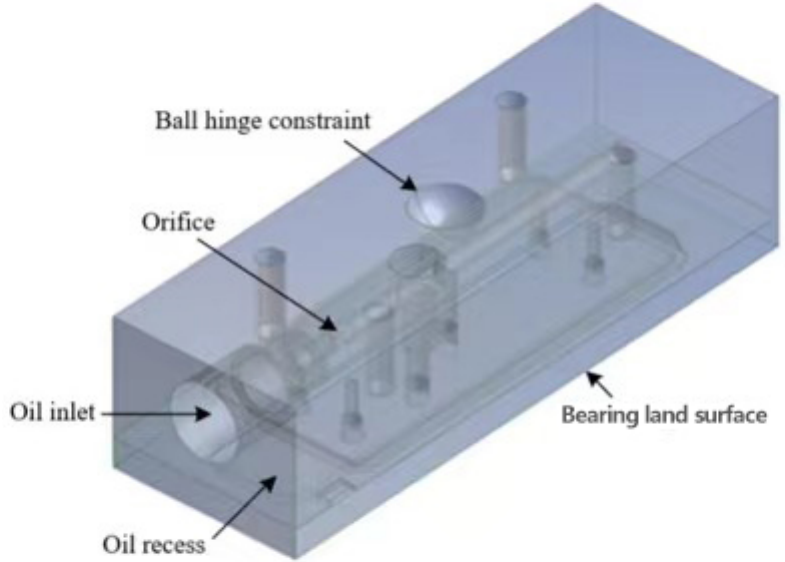
Figure 3. CAD model of the hydrostatic